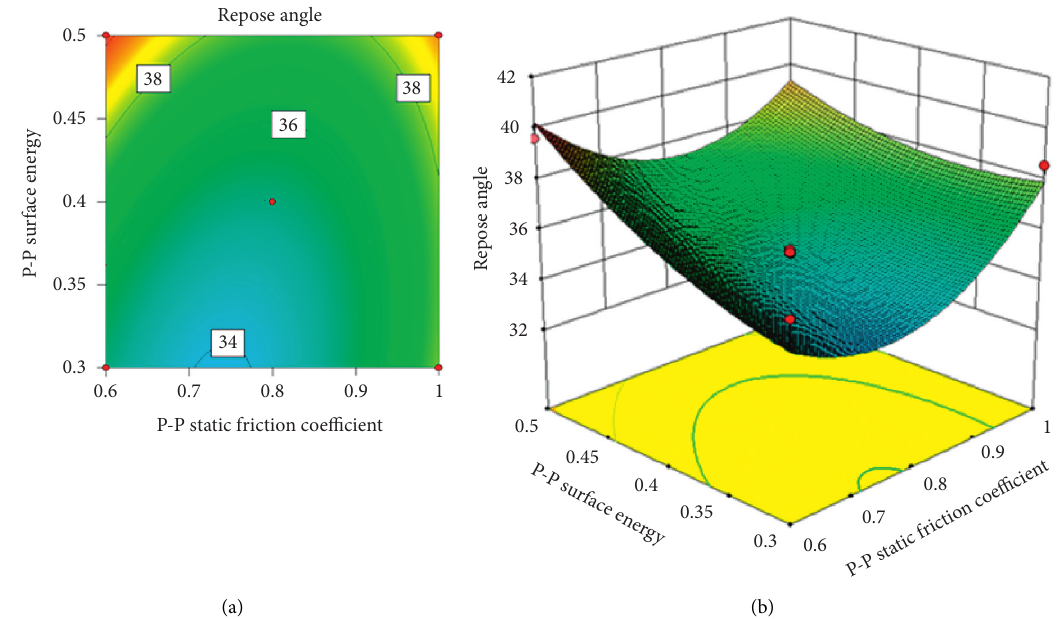
Figure 11: The plot of contour and response surface (P-P static friction coefficient and surface energy) (a) The contour plot (b) The response surface